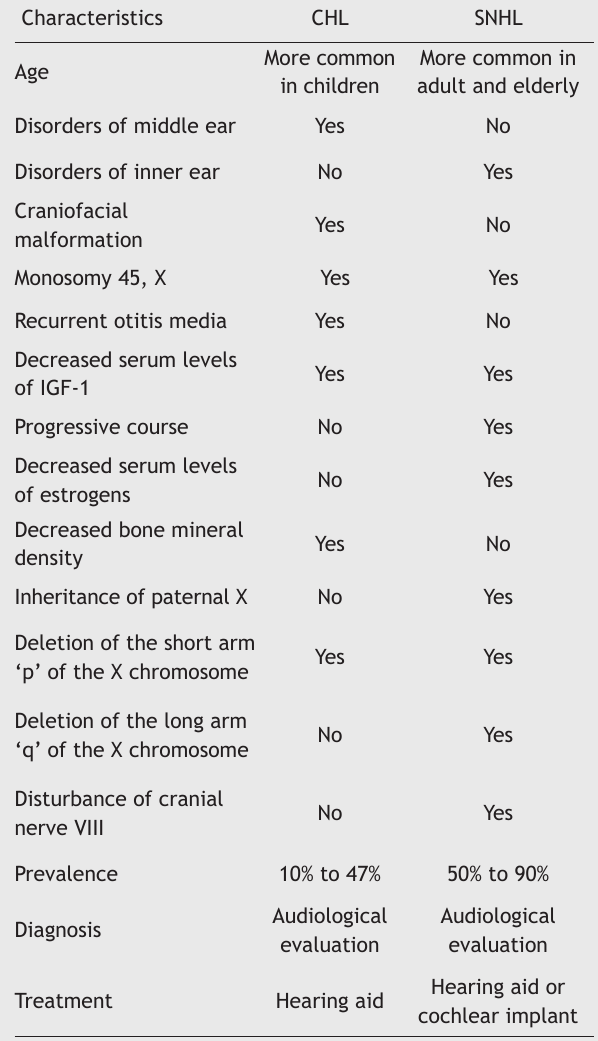
Table 1 Main characteristics of Conductive (CHL) and Senso- rioneural (SNHL) hearing loss in turner